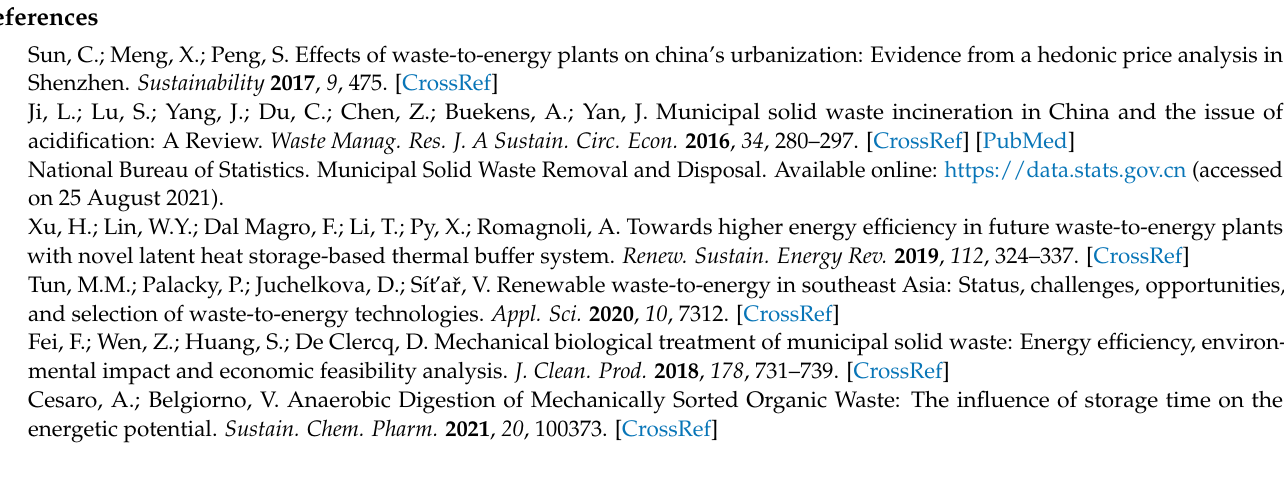
Figure A1. Models of the researched power generation systems in EBSILON Professional. ( a ) Model of the reference WTEU; ( b ) model of the reference CFPU; ( c ) model of the integrated power genera- tion